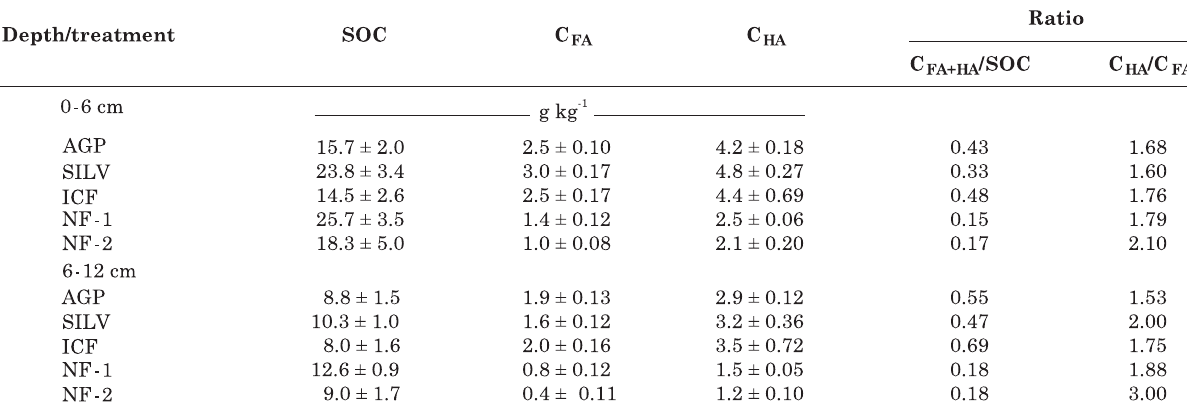
SOC: total soil organic carbon; C : carbon content in the fulvic acids; C : carbon content in the humic acids; AGP: agrosilvopasture; FA HA SILV: silvopasture; ICF: intensive cultivation under fallow; NF-1: native forest compared to AGP and SILV treatments; NF-2: native forest compared to the ICF